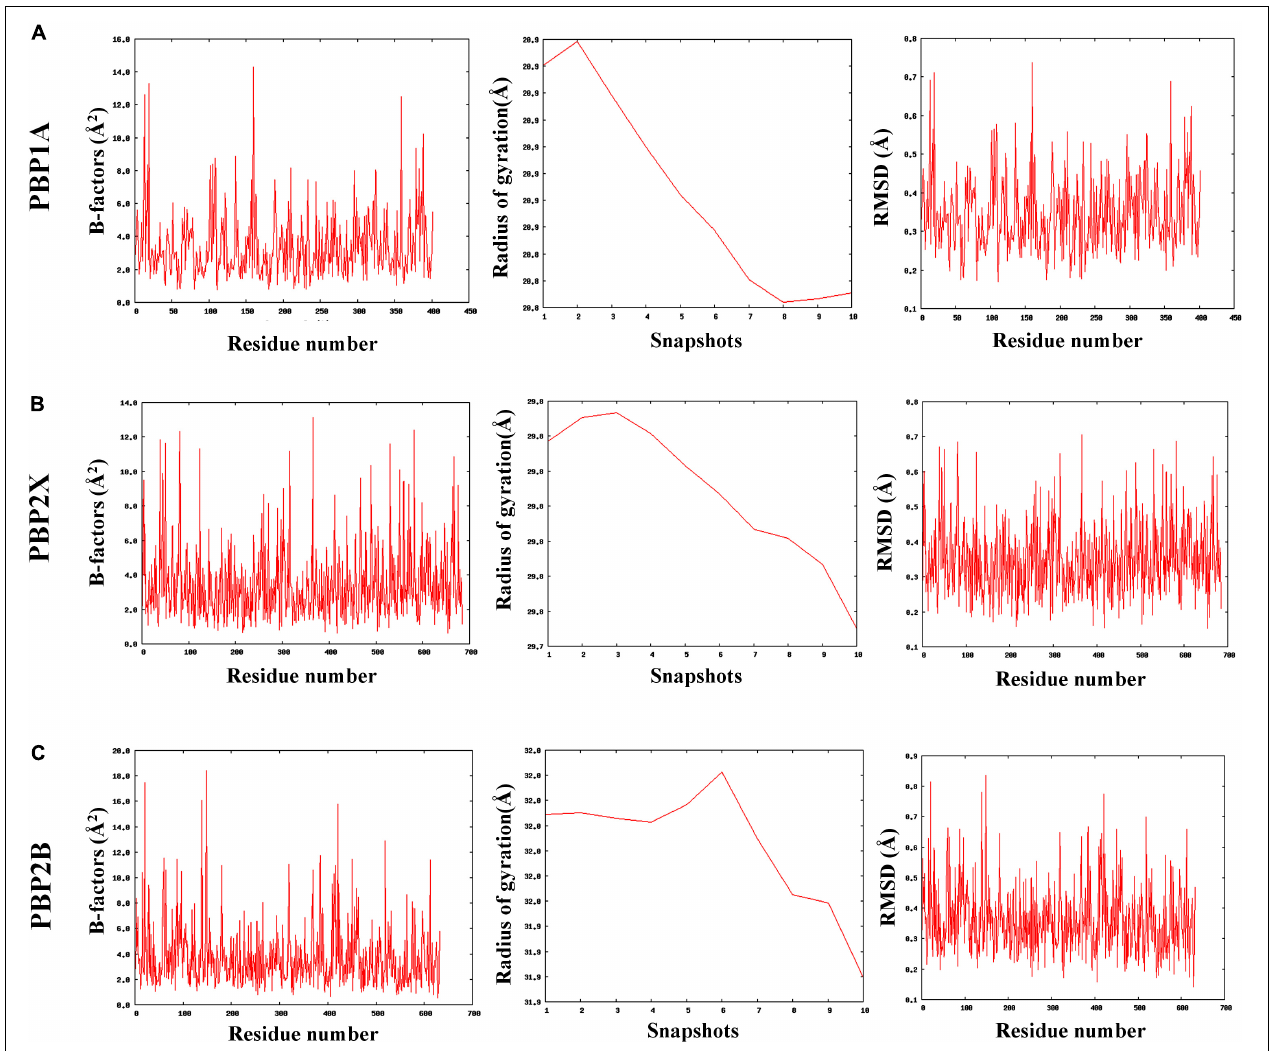
FIGURE 2 | The coarse-grained molecular dynamics simulated trajectories of (A) PBP1A, (B) PBP2X, and (C) PBP2B revealed overall stability in protein structures despite accumulated